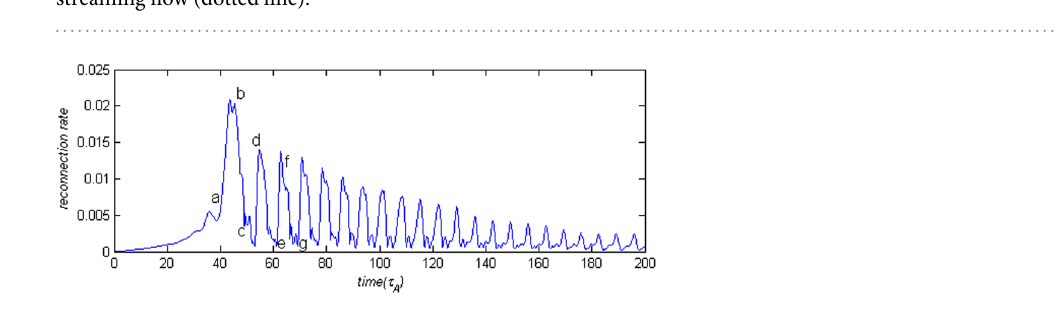
Figure 4. Time evolutions of the current density in the linear phase for three different cases: magnetic reconnection with streaming flow (solid line) and without streaming flow (dashed line), no reconnection with streaming flow (dotted line).